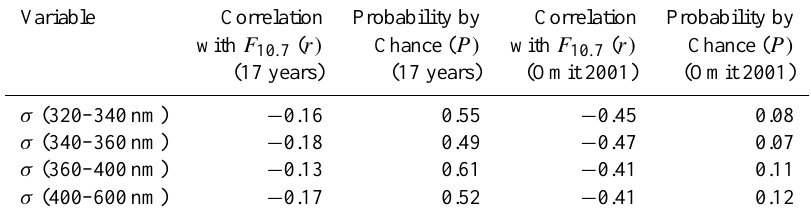
Table 7. Correlation of standard deviations of irradiance ratios ( σ ) with the 10.7cm solar radio flux. Variable Correlation Probability